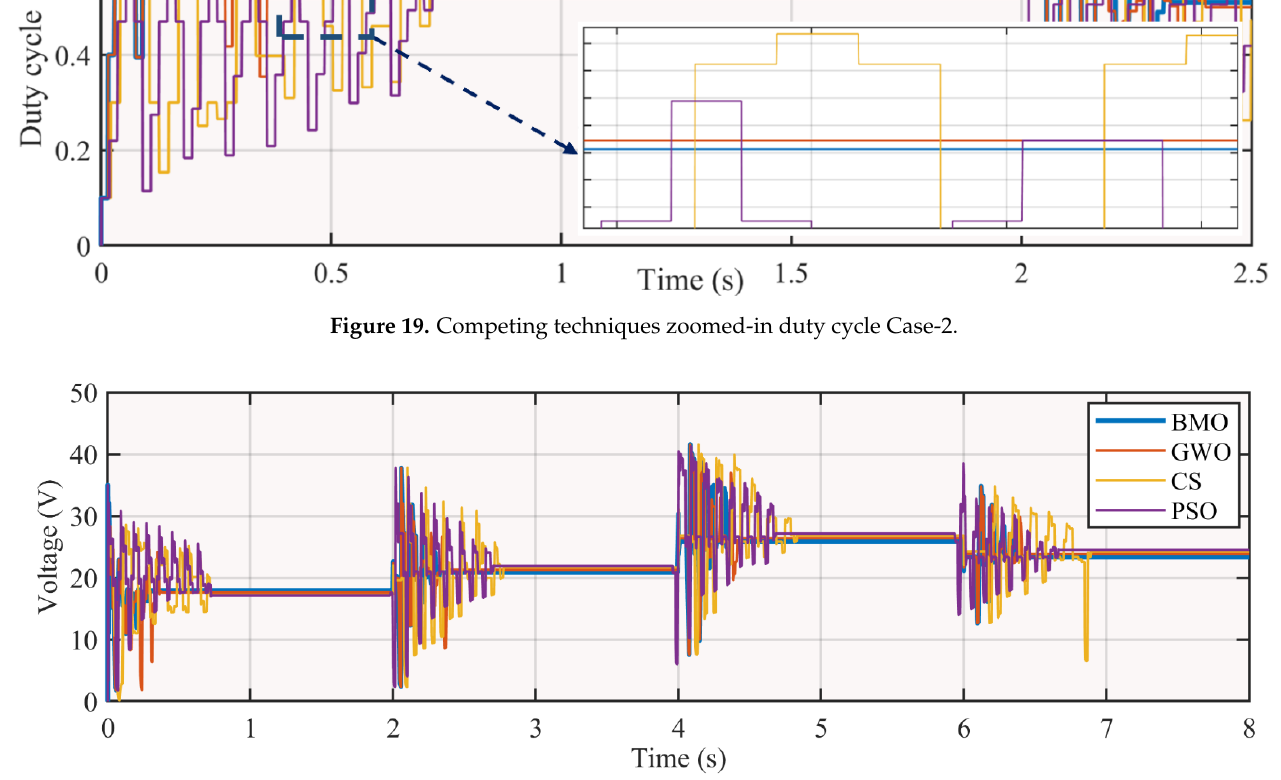
Figure 20. Competing techniques voltage Case-2.